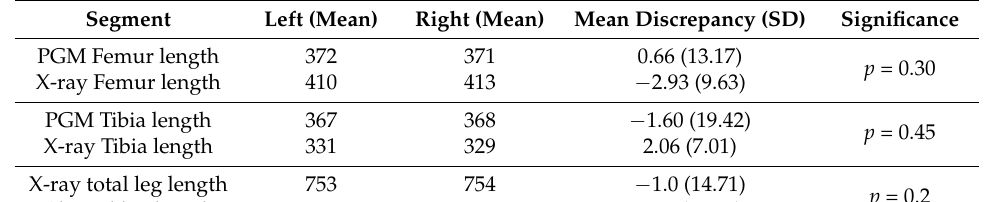
Table 1. Plug-in-Gait-model (PGM) versus X-ray segmental length, total X-ray length, clinical leg length and discrepancies (mm). Significance represent comparison of mean discrepancies. Level of significance— p < 0.01.